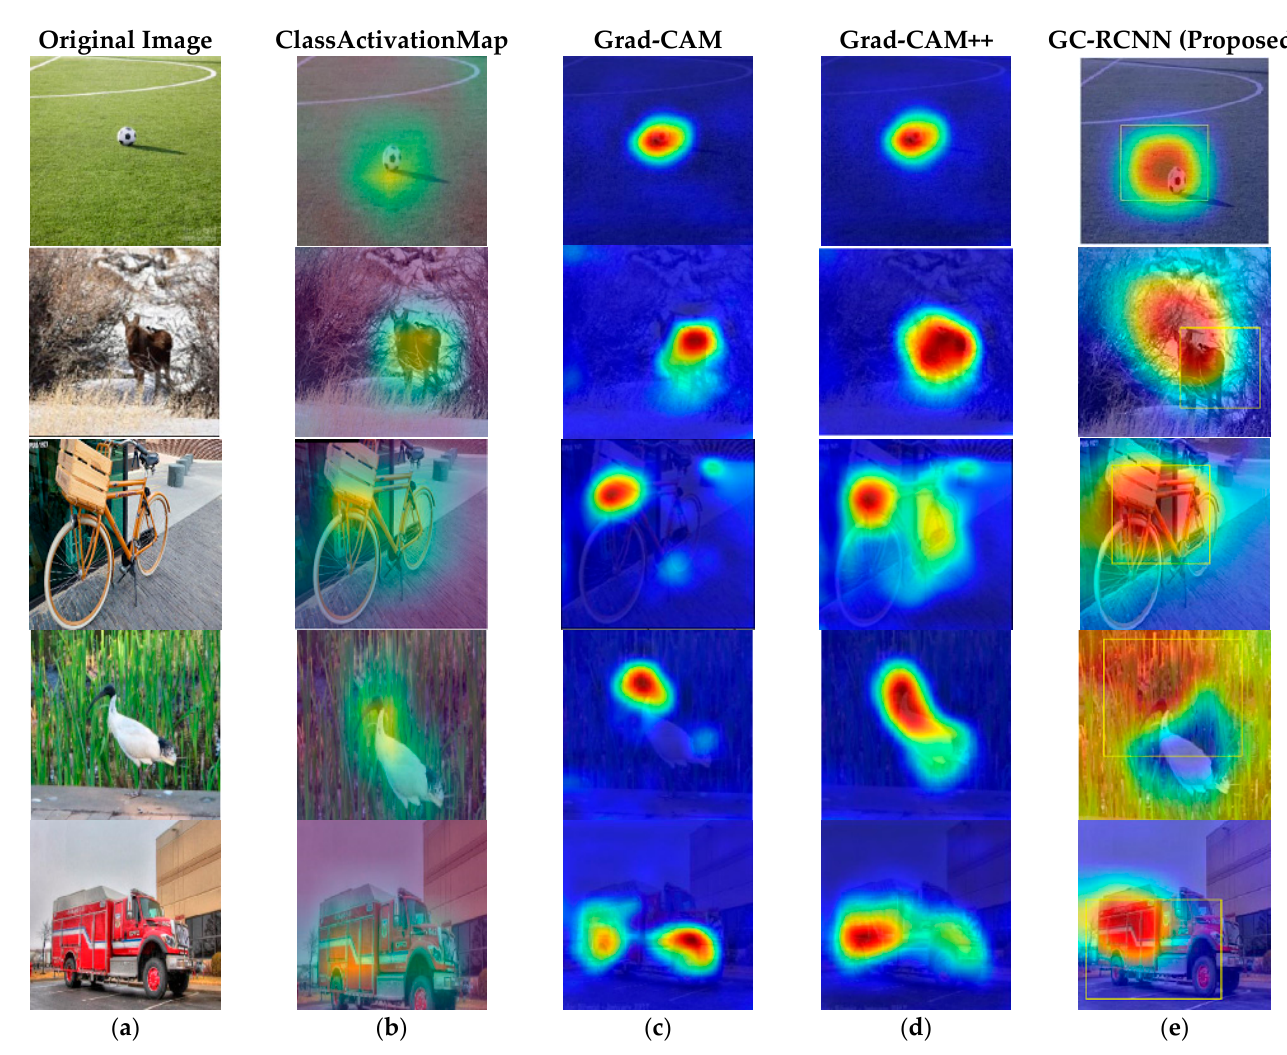
Figure 4. ( a ) Original image; ( b ) Class Activation Map; ( c ) results of Grad-CAM; ( d ) results of Grad-CAM++; and ( e ) GC- MRCNN. Various original images and its results of Grad-CAM, Grad-CAM++, and the proposed algorithm (GC-MRCNN).